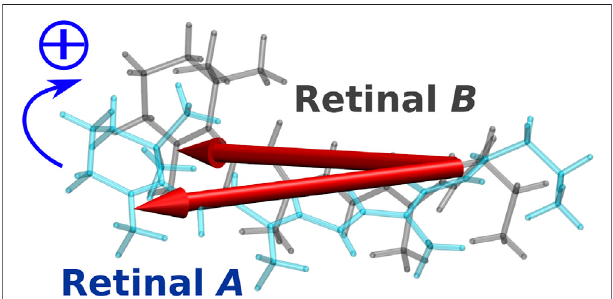
FIGURE 9 | Intermolecular conformation of the two retinal chromophores (retinal A and retinal B ) in KR2. The two red arrows represent the transition dipole moments of the two retinal